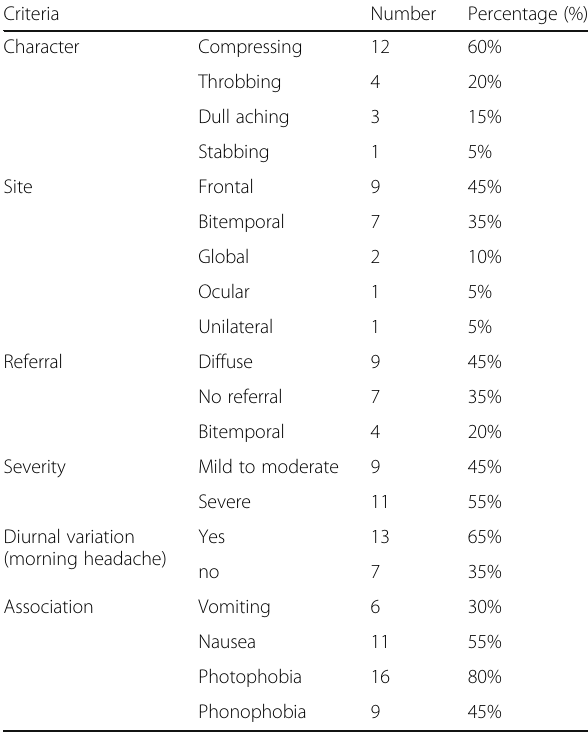
Table 2 Clinical criteria of headache in IIH patients